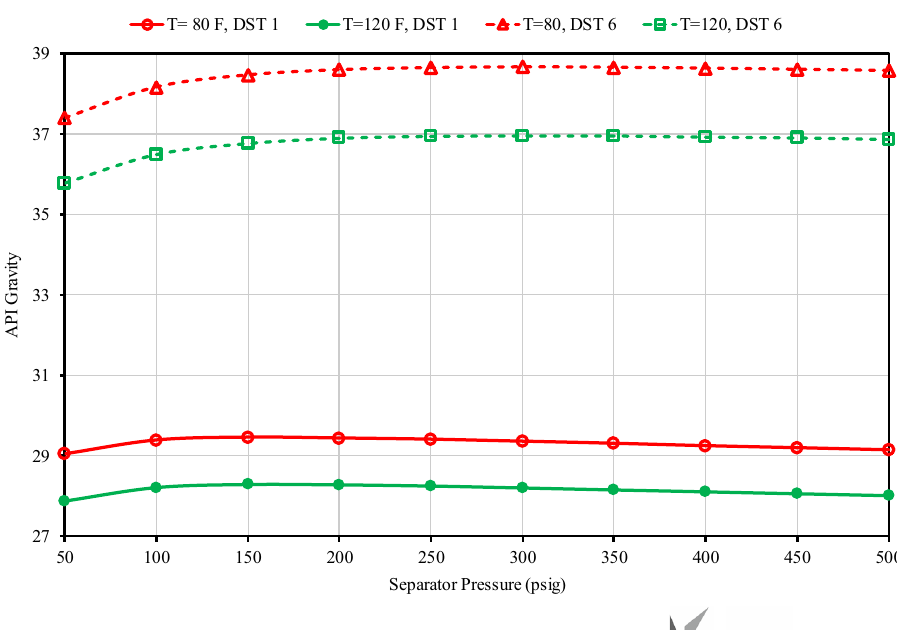
Fig. 9 HYSIS simulation model for two different sets of PVT data